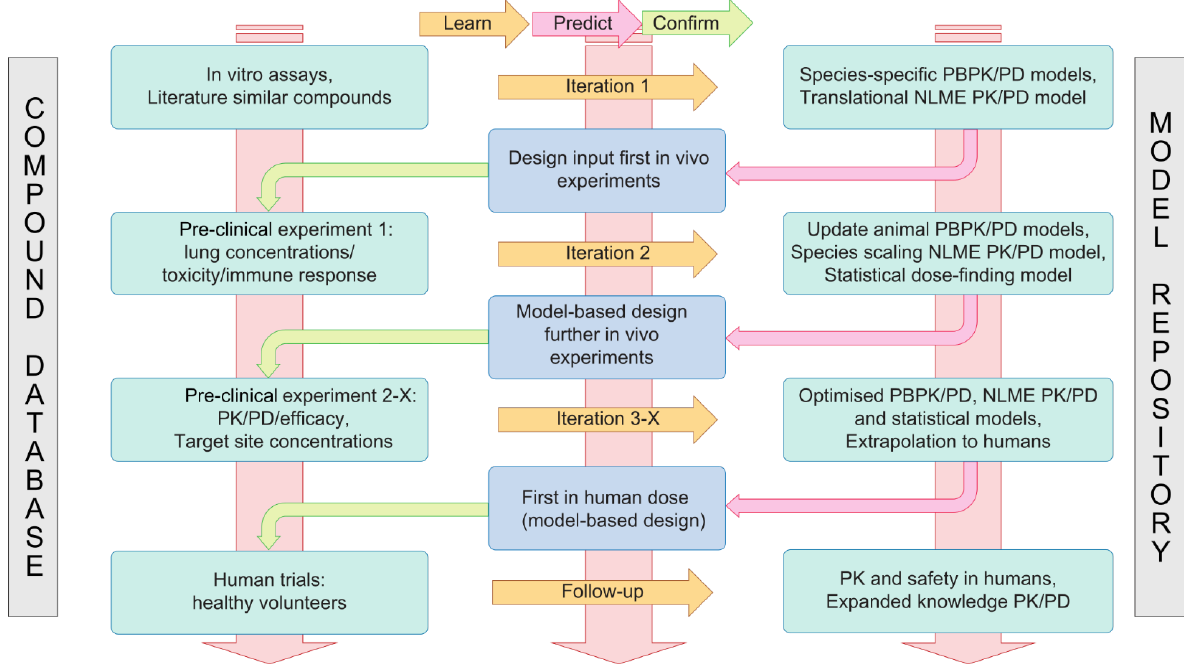
Figure 1. The developed translational modelling and simulation platform for integration, exploitation, and modelling of an immunomodulatory compound’s PK/PD. Starting from the literature and pre-existing datasets, the platform enables the design of appropriate preclinical experiments and novel data to implement the model in order to perform dose finding for clinical trials. This process can be iterated multiple times to predict the PK/PD and doses to be used in phase I trials and beyond. PD: pharmacodynamics; PK: pharmacokinetics; NLME PK/PD: nonlinear mixed effects PK/PD; PBPK/PD: physiologically based PK/PD.